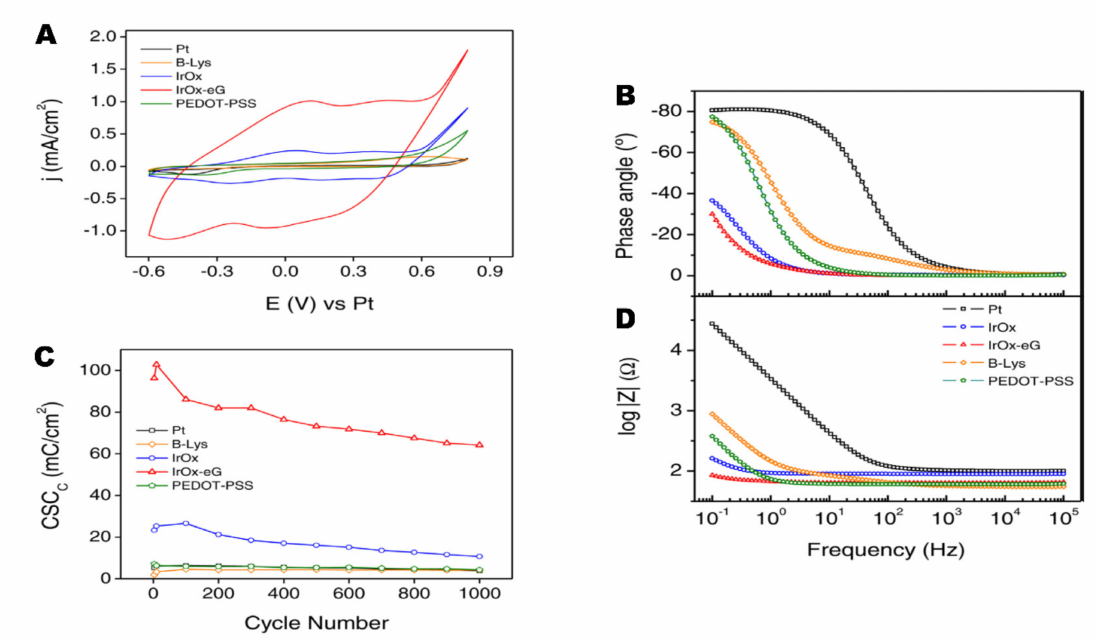
Figure 8. (A ) Cyclic voltammetries in biologically emulating sodium phosphate buffer of representative nanostructured IrO x –graphene hybrids during electric field application in electrostimulation processes and ( B ) associated charge storage capacity changes during 1000 cycles. ( C ) Graphite hybrid, not shown sees the CSC decrease after a few cycles, to the IrO x values. ( D ) Impedance comparison for several materials [34]. With permission from Elsevier.